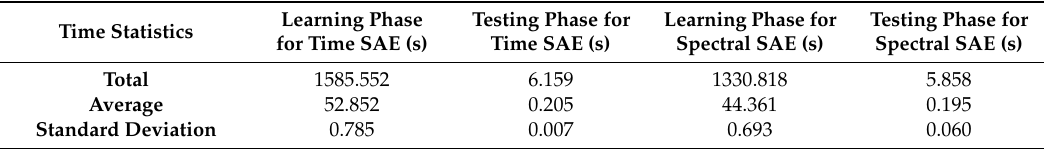
Table 8. Computation time of STALAD phases over 30 SVIDs for the experiment in Section 6.2.